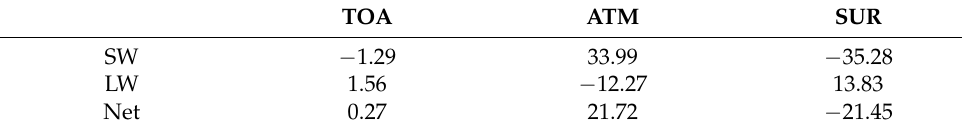
Table 3b . Same as Table 3a, but for the daytime. Unit: Wm − 2 . TOA